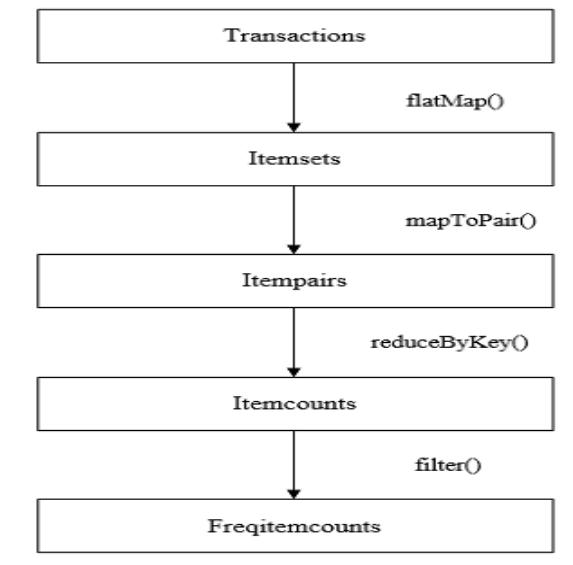
Fig 1:- RDD of Apriori Phase 1